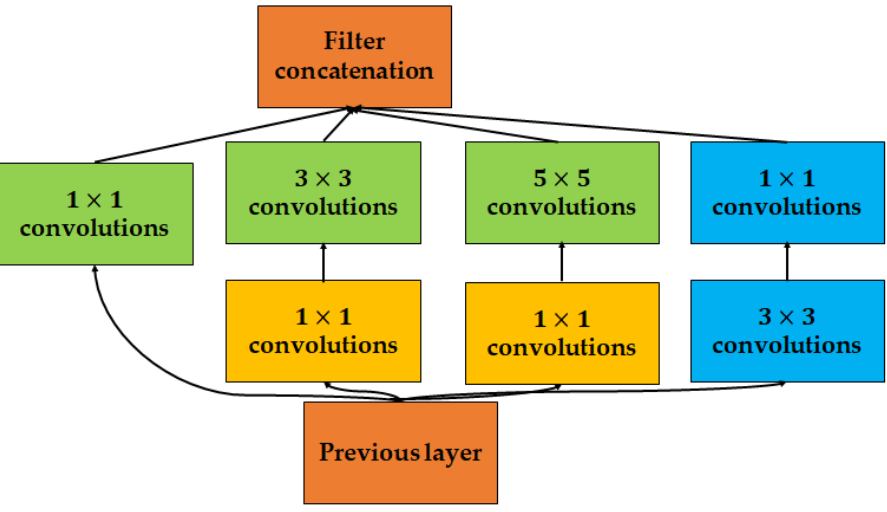
Figure 13. Basic structure of the inception block in GoogLeNet.